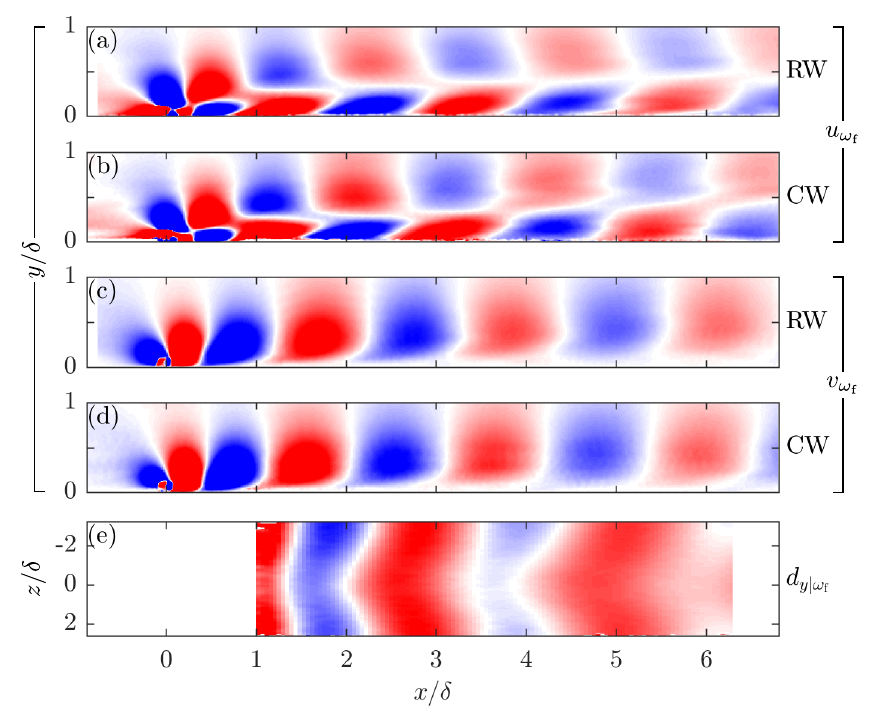
Figure 5. Phase snapshots ( j = 0) of the RW-DRF and CW-DRF ω f coherent ( a – d ) velocity and ( e ) wall-normal deformation fields, all from actuation condition iii. For the velocities, the ( a , c ) RW rigid- and ( b , d ) SW smooth-wall data are given for comparison, and the contour shading limits are ± 0.02 U ∞ (red/blue indicate high/low speed). For the wall-normal deformation, the contour shading limits are ± 6